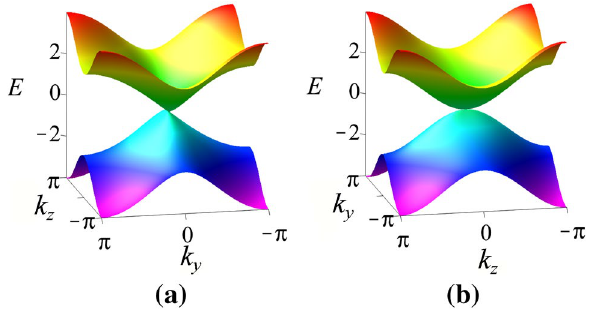
0 . ( a ) Along k y and ( b ) along k z with 1 for k x = =